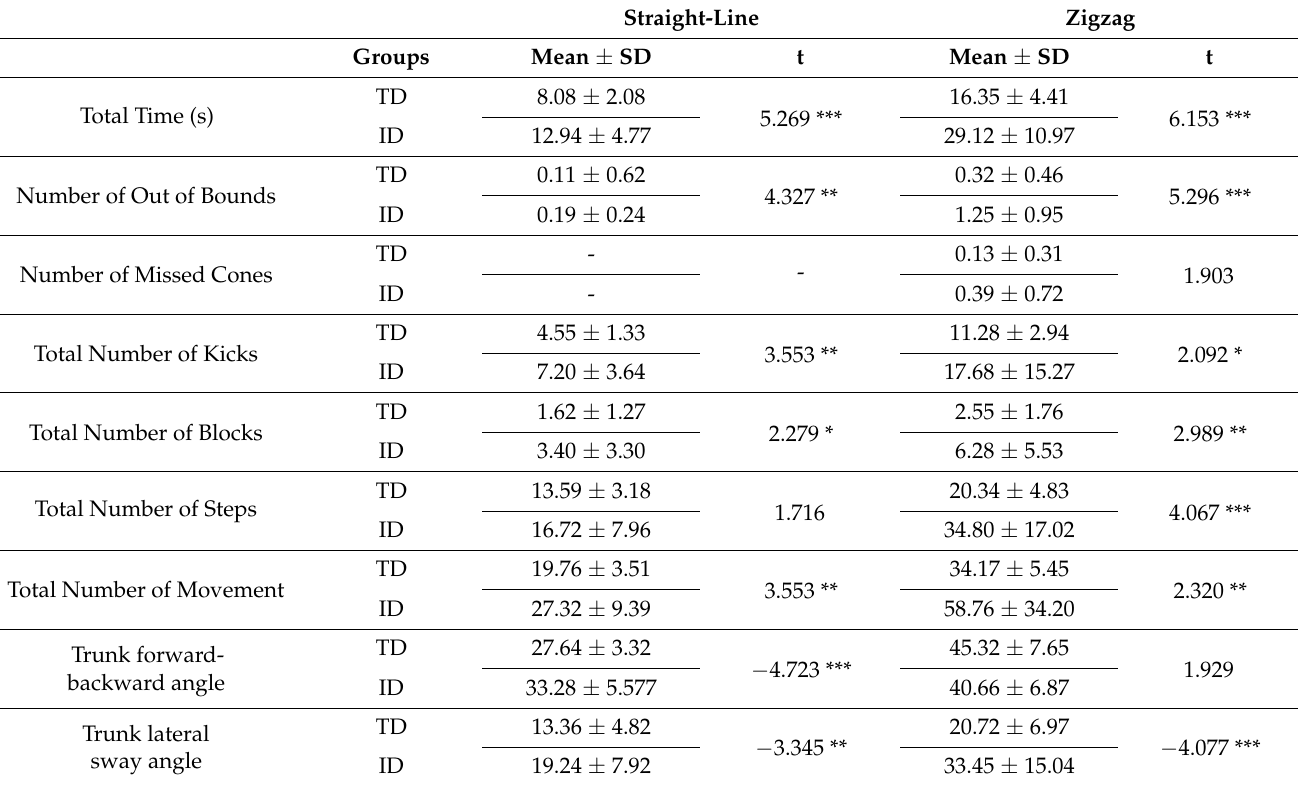
Table 4. Results for various dribbling